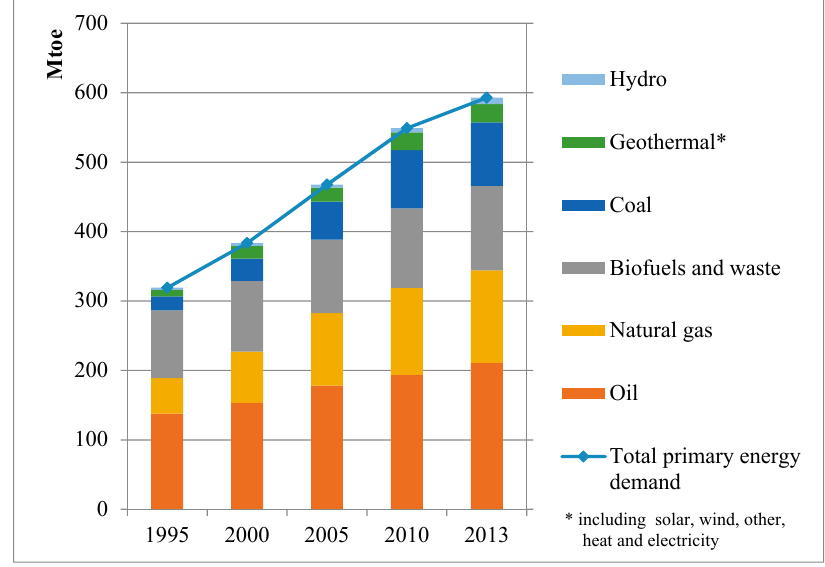
Figure 4. Total energy production in ASEAN by source (calculated from IEA database 2015).